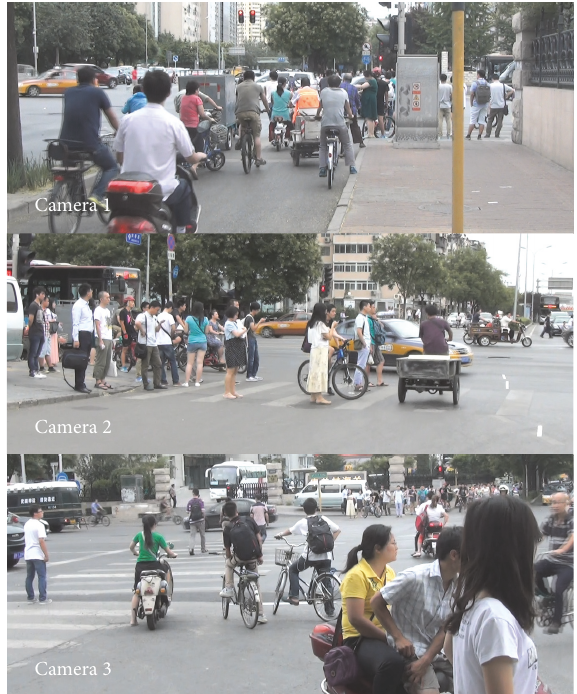
Figure 3: Photographs from Cameras 1, 2, and 3 at Zhongguancun East Rd.-Zhichun Rd.